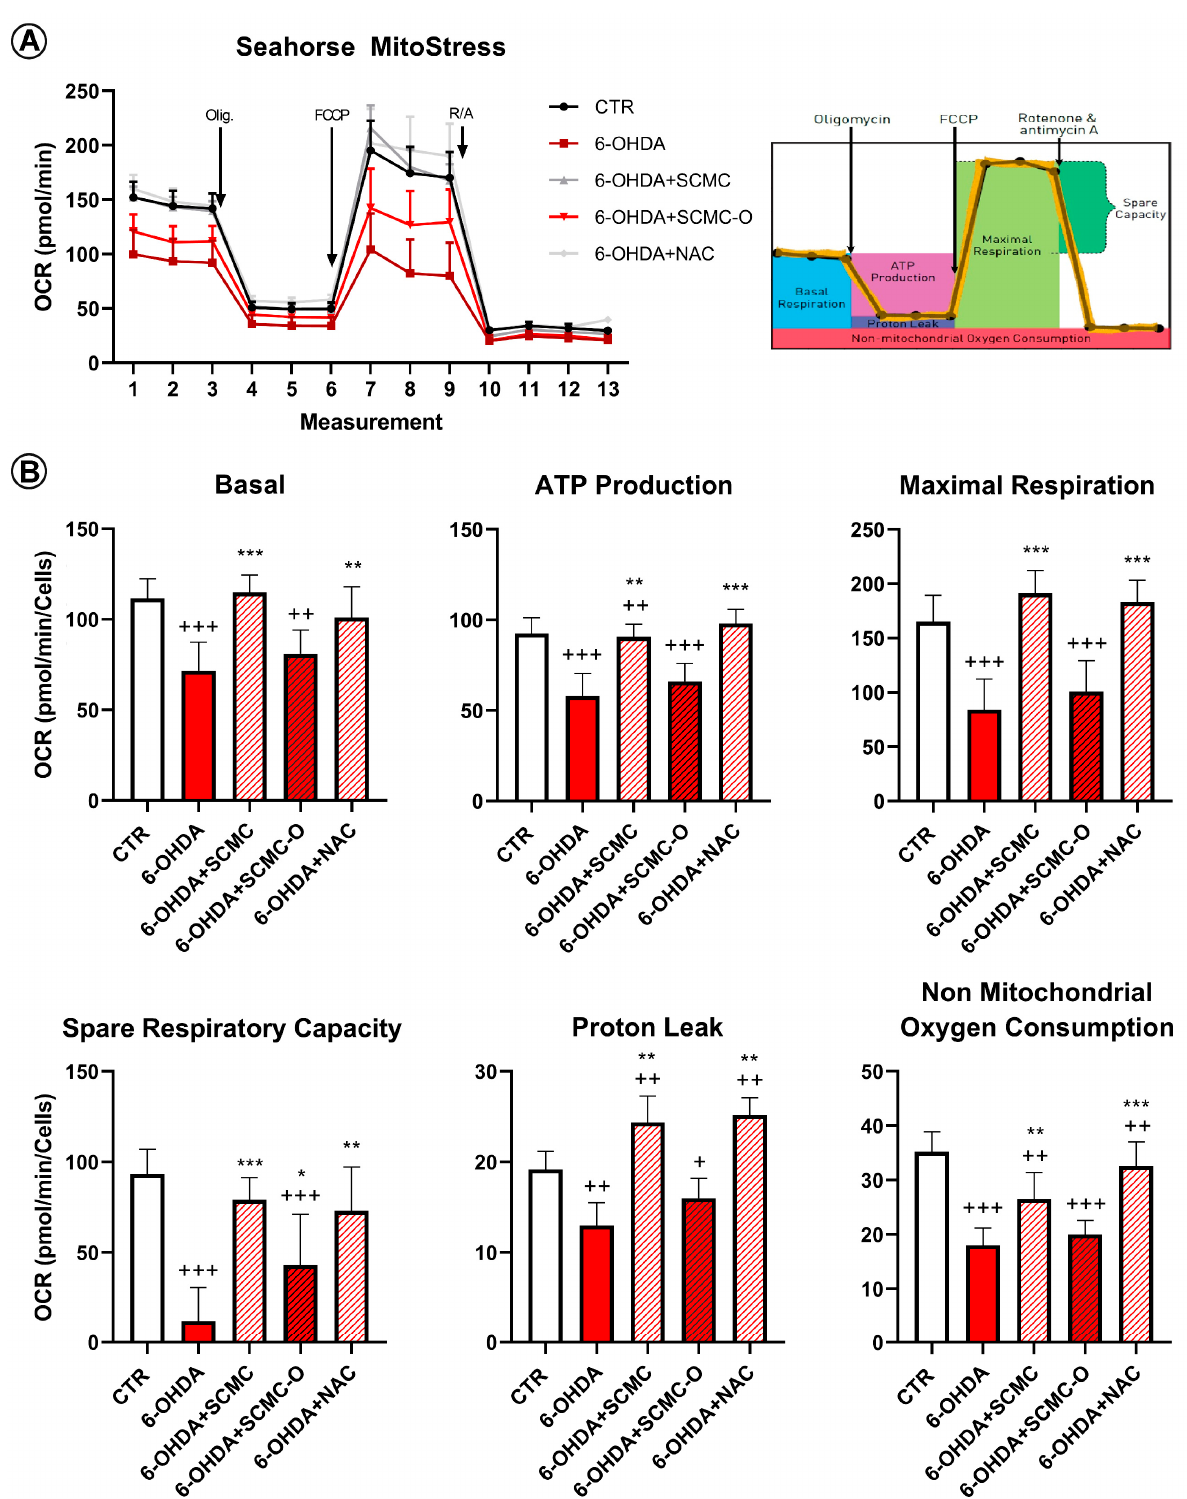
Figure 9. Mitochondrial bioenergetic profile in CTR and treated cells. ( A ) Seahorse XF Cell Mito Stress profile illustrated the key parameters of mitochondrial function upon the injection of different drugs. ( B ) Graph relative to basal respiration, ATP production, maximal respiration, and non-mitochondrial respiration in CTR and treated cells. Data are mean ± SD of three different experiments. *** p < 0.0001, ** p < 0.005, * p < 0.05 vs. 6-OHDA; +++ p < 0.0001; ++ p < 0.005, + p <0.05 vs. CTR.